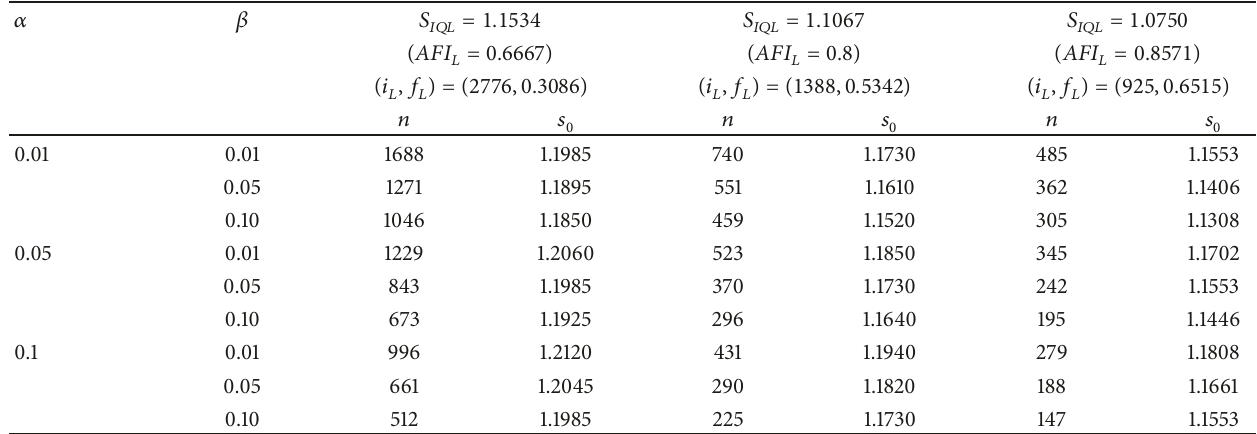
Table 3: The values of (𝑛,𝑠 0 ) at 𝑆 AOQL = 1.2485 ( AOQL = 0.00018) and three levels of 𝑆 𝐼𝑄𝐿 (𝐴𝐹𝐼 𝐿 ) for 𝛼 = 0.01, 0.05, and 0.1 and 𝛽 = 0.01, 0.05, and 0.1 .